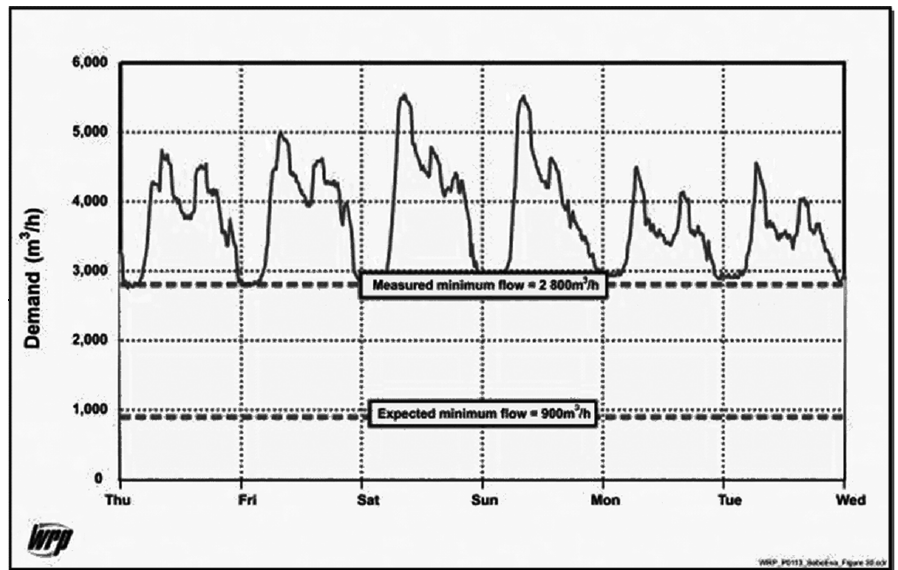
Figure 2: Initial water demands for a 6-day period entering Sebokeng and Evaton in July of 2003 TD , 3(2), December 2007, pp.